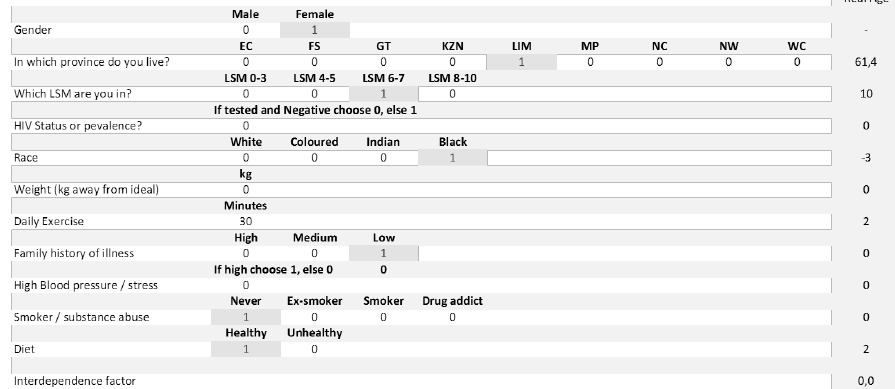
FIGURE 7: Graphical interface showing simulation of Person_Y Source: